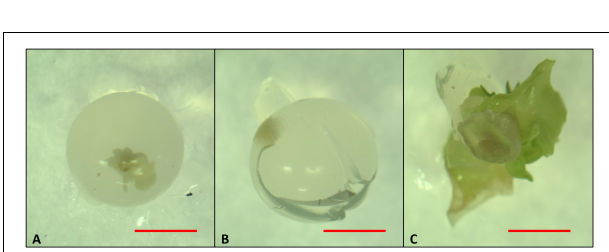
FIGURE 7 | Hardness of the calcium alginate capsules prepared with different sodium alginate and CaCl 2 concentrations.